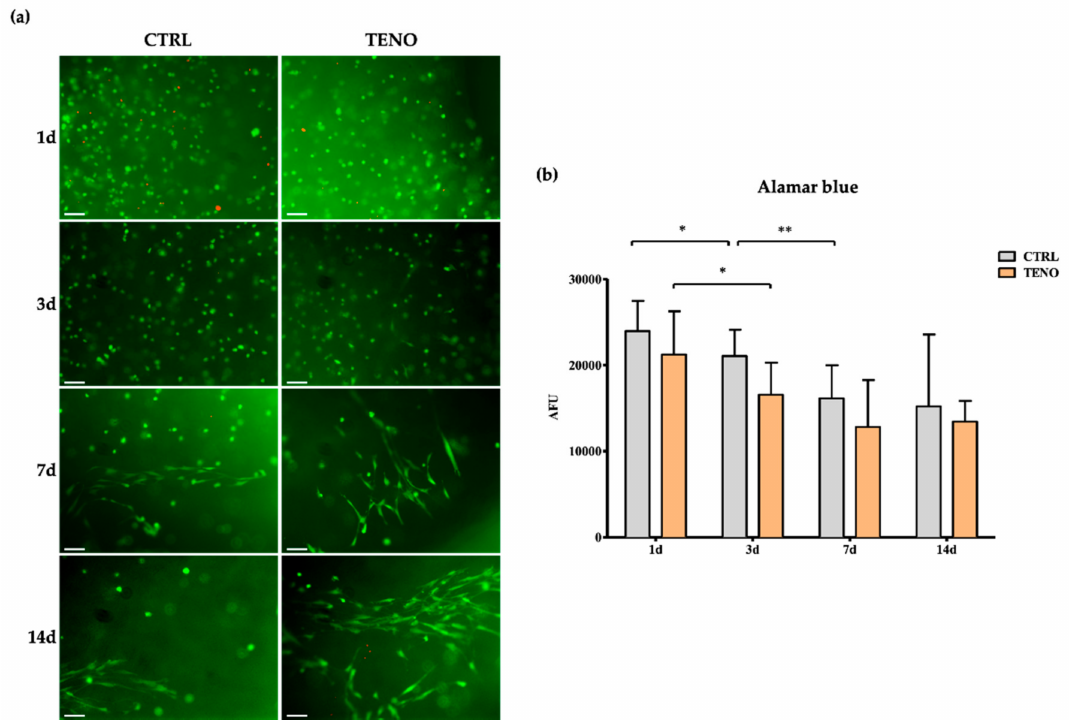
Figure 6. Cell viability: ( a ) representative images of live (green) and dead (red) cells encapsulated in the sca ff olds at a cell density of 6.0 × 10 6 cells / mL and cultured in undi ff erentiated (CTRL) and di ff erentiated (TENO) medium after 1, 3, 7 and 14 days of cell culture (10 × magnification; scale bar 10 µ m: N = 3); ( b ) cell viability of encapsulated ASCs at 1, 3, 7 and 14 days of cell culture ( N = 3). Data were expressed as average ± standard deviation of arbitrary fluorescence units (AFU). Level of significance: ** p < 0.01, * p <